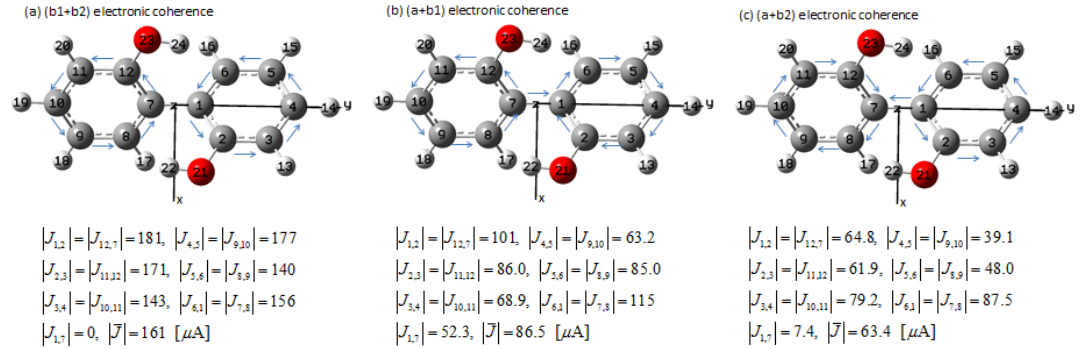
Figure 11. Bond currents for the three types of the electronic coherence at a time when the maximum electronic coherence is created. Modified from [87] with permission of the American Institute of Physics.